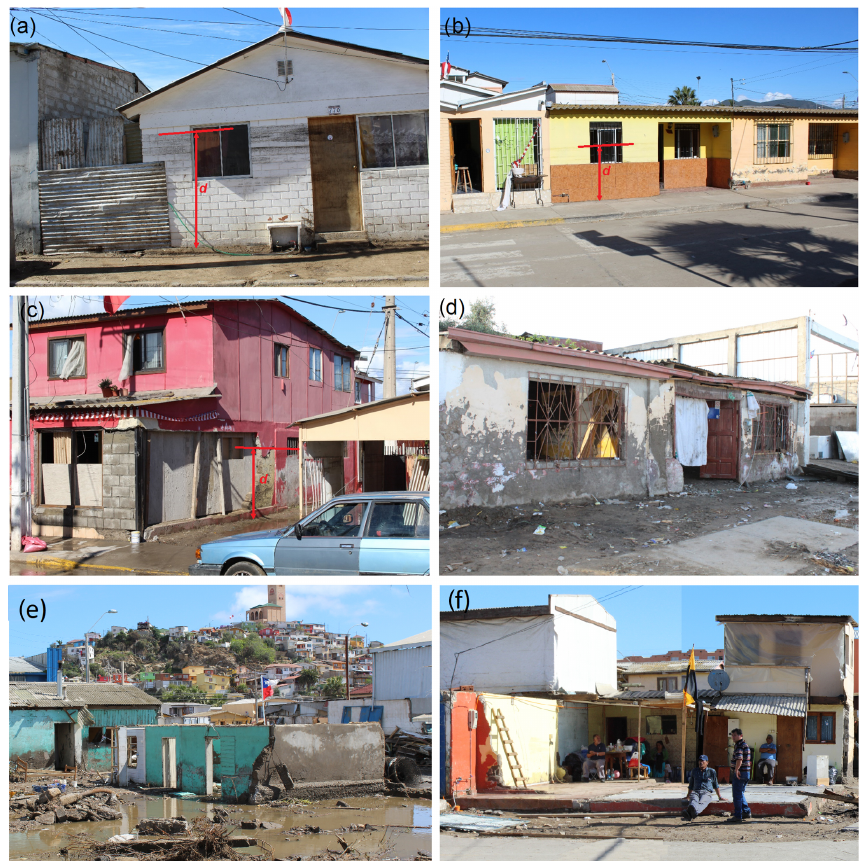
Figure 2. Photographs of structures undamaged and masonry houses damaged by the 16 September 2015 tsunami in the Coquimbo area. The red letter d indicates the observed tsunami inundation depth. All photos were taken on 22 September